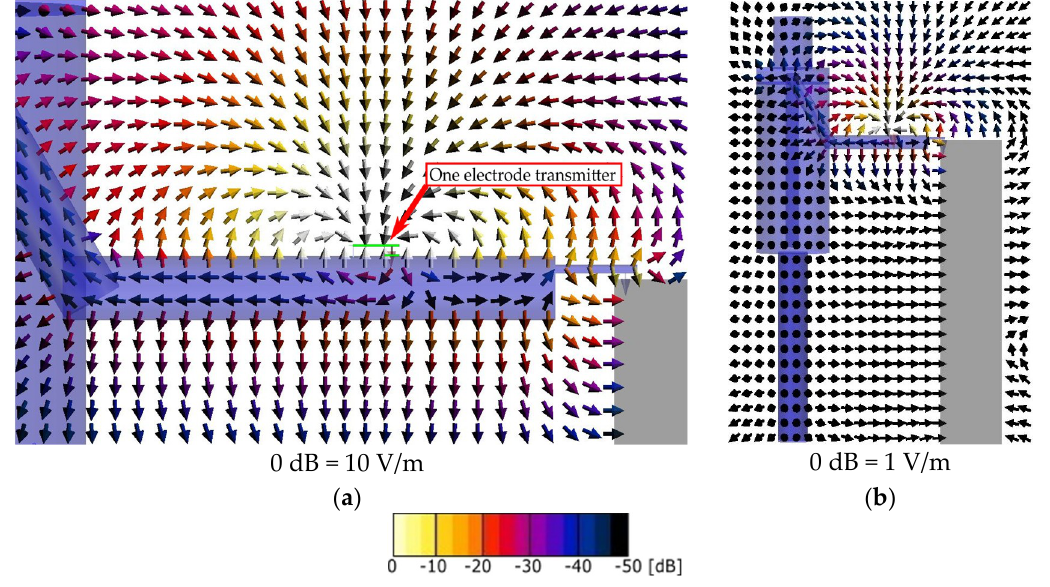
Figure 5. Direction and strength of the electric field in the one-electrode transmitter case. ( a ) Distribution around the transmitter and the arm. ( b ) Distribution in a wider area including the whole human body.